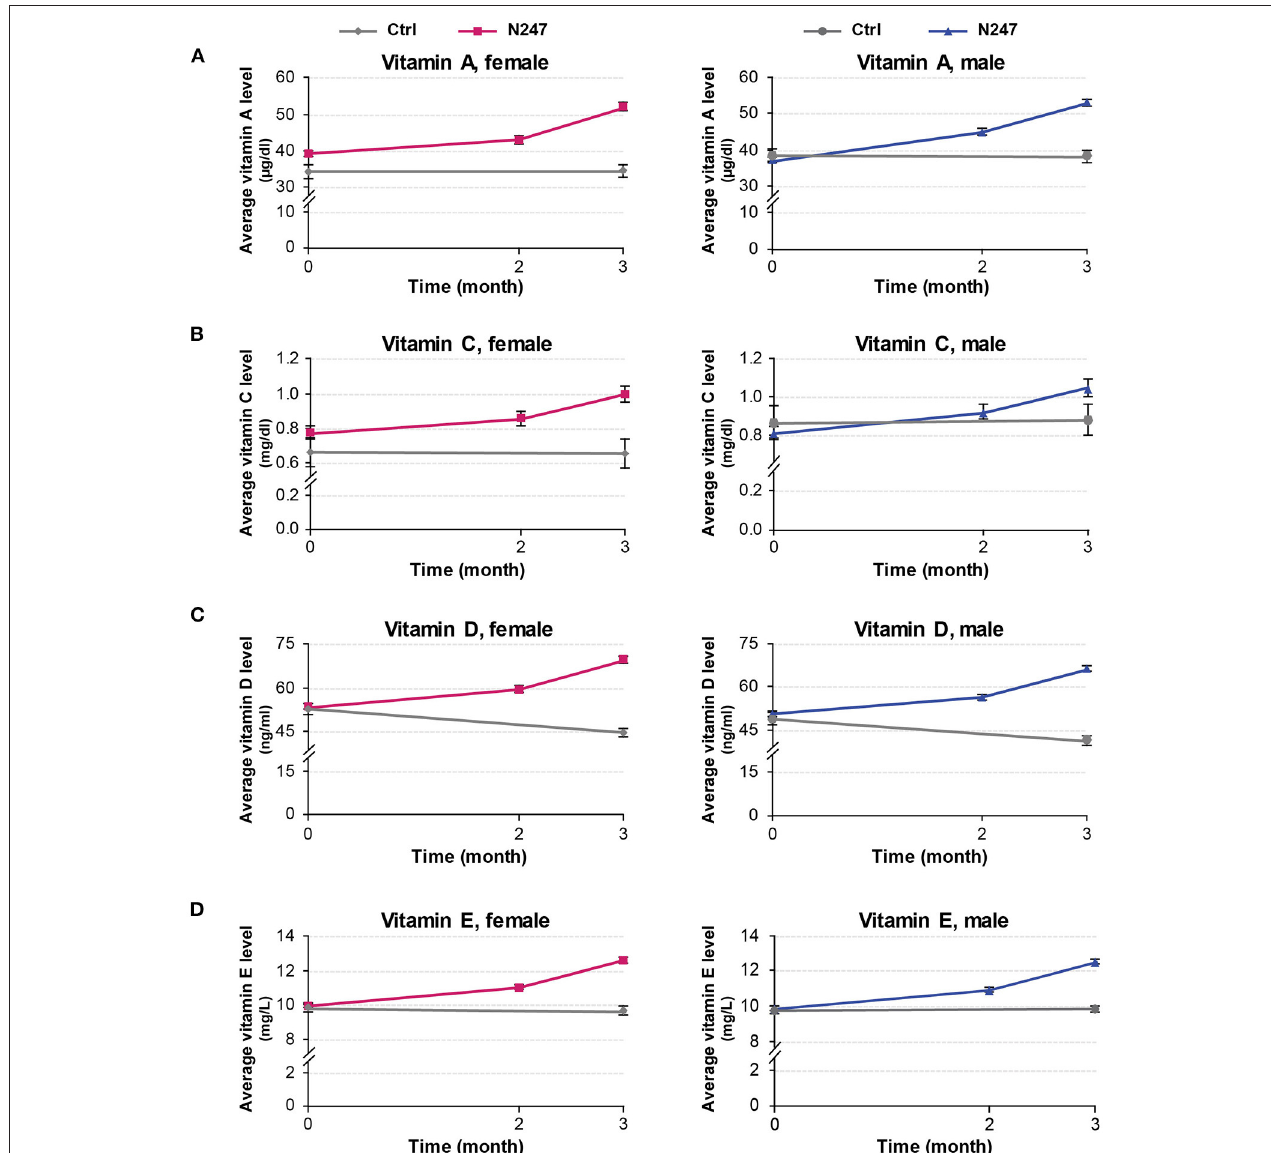
FIGURE 2 | Graphical representation of N247 effects on serum vitamin A, C, D, and E levels. Serum concentrations of vitamin A (A) , vitamin C (B) , vitamin D (C) , and vitamin E (D) in control and N247 receiving group of women and men subjects during the study. Values are mean